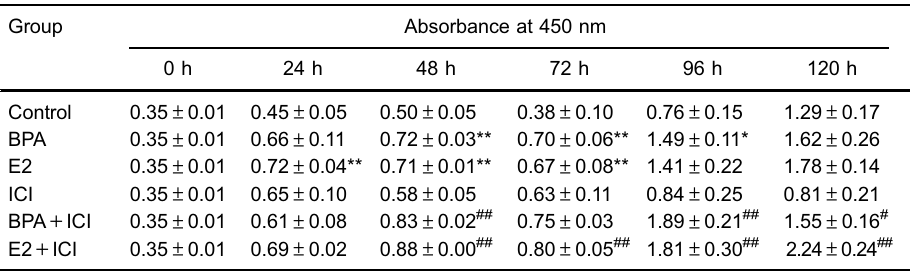
Table 1. Effect of bisphenol A (BPA) and estradiol (E2) on HepG2 cell viability.